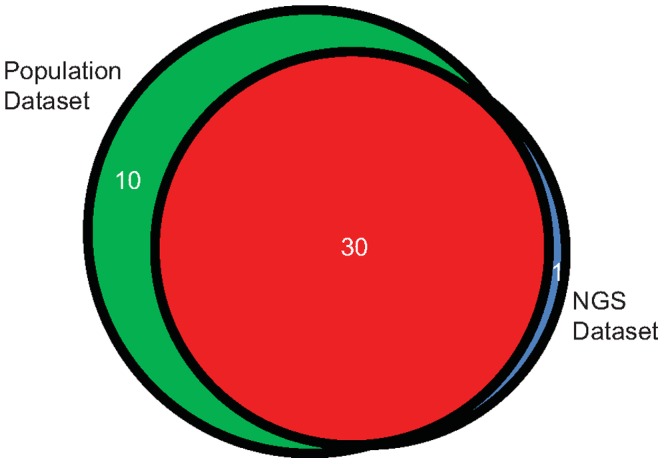
Prediction of VTCs by two studies using HIV-1 sequences obtained from pre-therapy subjects.Shown are comparisons of VTC numbers as predicted by NJ tree-reconstruction of either population-based, ultra-deep sequencing (UDS) or both datasets. See Methods and Materials for VTC prediction methodology.